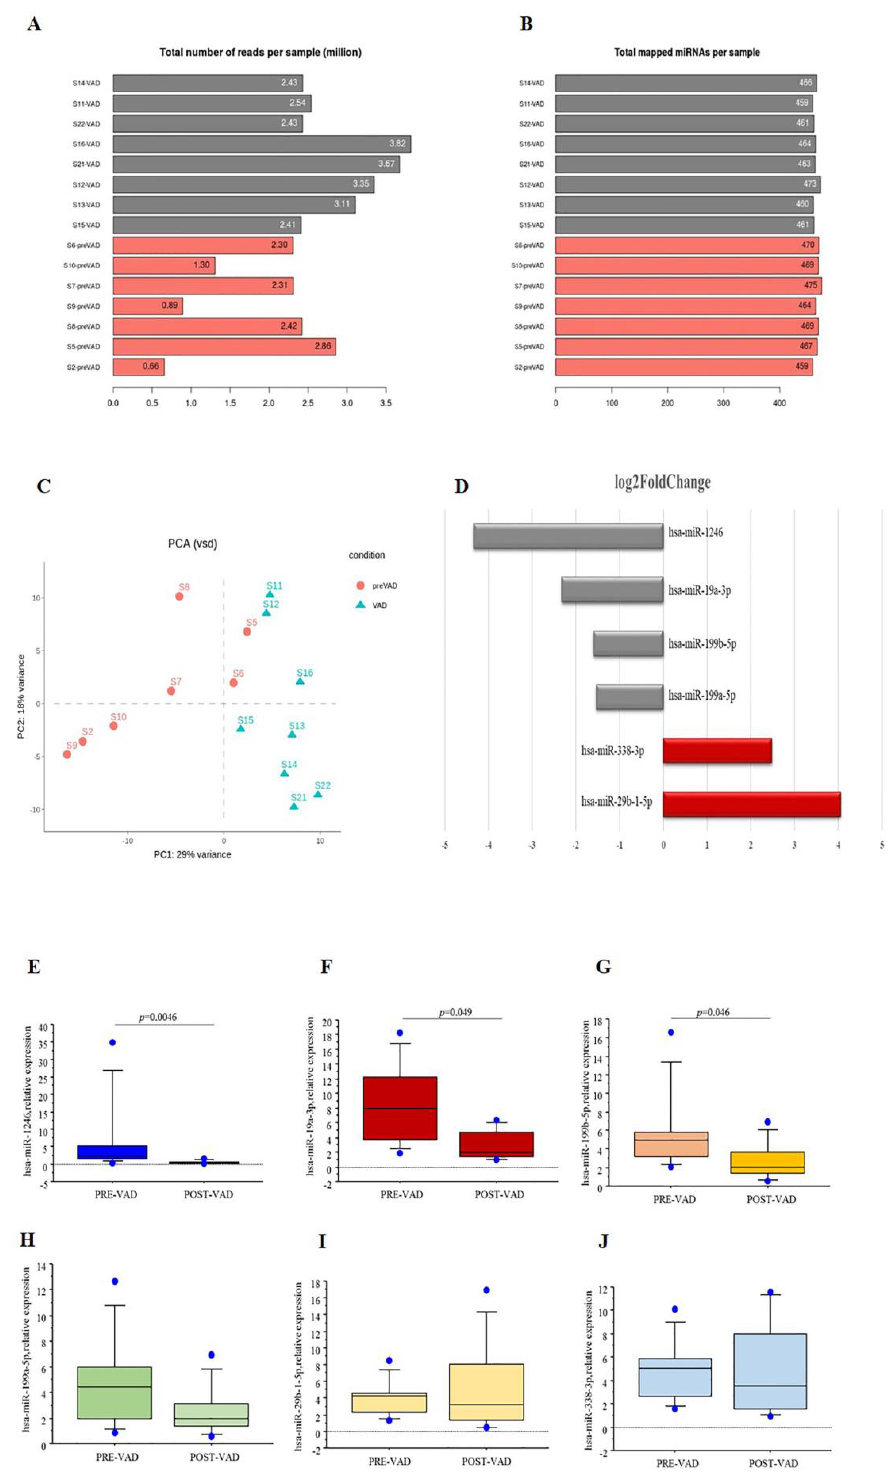
Figure 2. ( A ) Total number reads per sample. ( B ) Total mapped miRNAs per samples. ( C ) The distribution of miRNA among pre-VAD and post-VAD groups represented by Principal component analysis. ( D ) Differentially expressed cardiac miRNA from NGS experiments. Log 2 Fold Changes between pre- and post-VAD are showed (grey bars: downregulated miRNA; red bars: up-regulated miRNAs). Real-time PCR data analysis of differentially expressed ( E ) hsa-miR-1246, ( F ) hsa-miR-19a- 3p, ( G ) hsa-miR-199b-5p, ( H ) hsa-miR-199a-5p, ( I ) hsa-miR-29b-1-5p, ( J ) hsa-miR-338-3p in cardiac samples of HF children at pre-VAD compared to